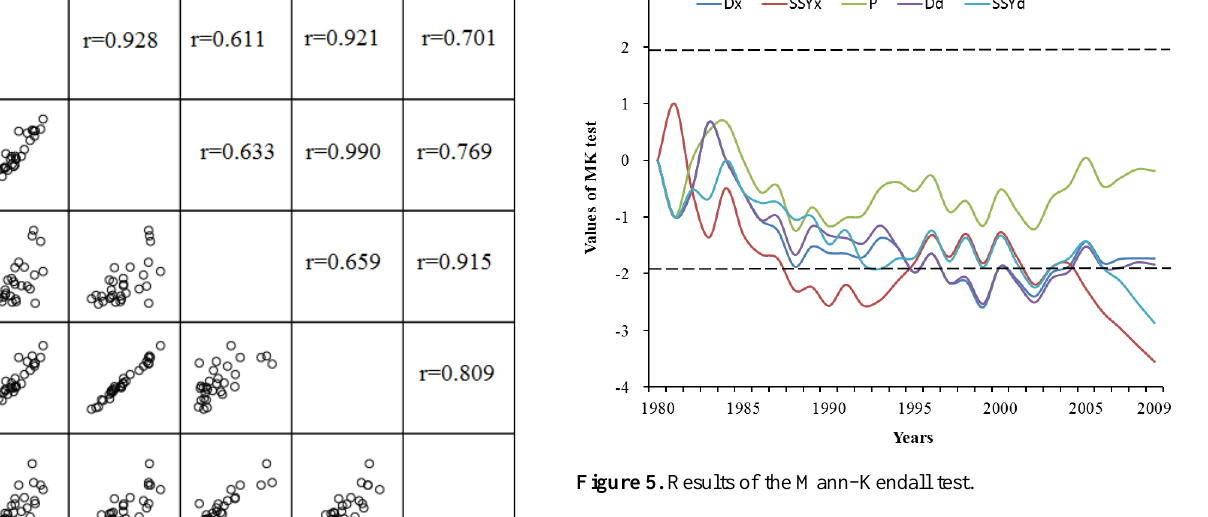
moderate flow (25 < Q < 75 %), and high flow ( Q ≥ 75 %). The SSC dynamics were compared under different flow regimes. For the sub-catchment, the thresholds were 188 and 674 m 3 s − 1 for the minimum 25 % and maximum 25 %, re- spectively. For Qd, the thresholds of the minimum and maxi- mum 25 % were 332 and 1100 m 3 s − 1 , respectively. Figure 8 presents box plots for SSCd and SSCx during the three pe- riods for the three flow grades. The box plots indicate the maximum, 75, 50 and 25 %, and minimum values for each SSC (outliers are excluded). For the sub-catchment, SSCx increased between the original period and the cultivation pe- riod for moderate and high flow, but not for low flow. Then, SSCx decreased during the reforestation period for all flows. At the Zhushan station, SSCd was larger during the